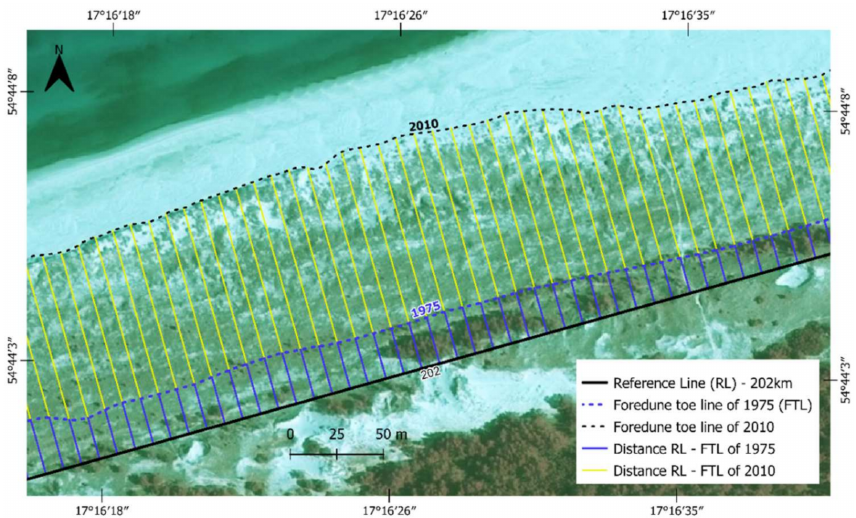
Figure 4. Transects perpendicular to the reference line (MOK) determined at intervals of 10 m. The distance was defined as the reference line—foredune toe lines in a given year: RL-FTL 2010; RL-FTL 1975. The base map—orthophotomap dated